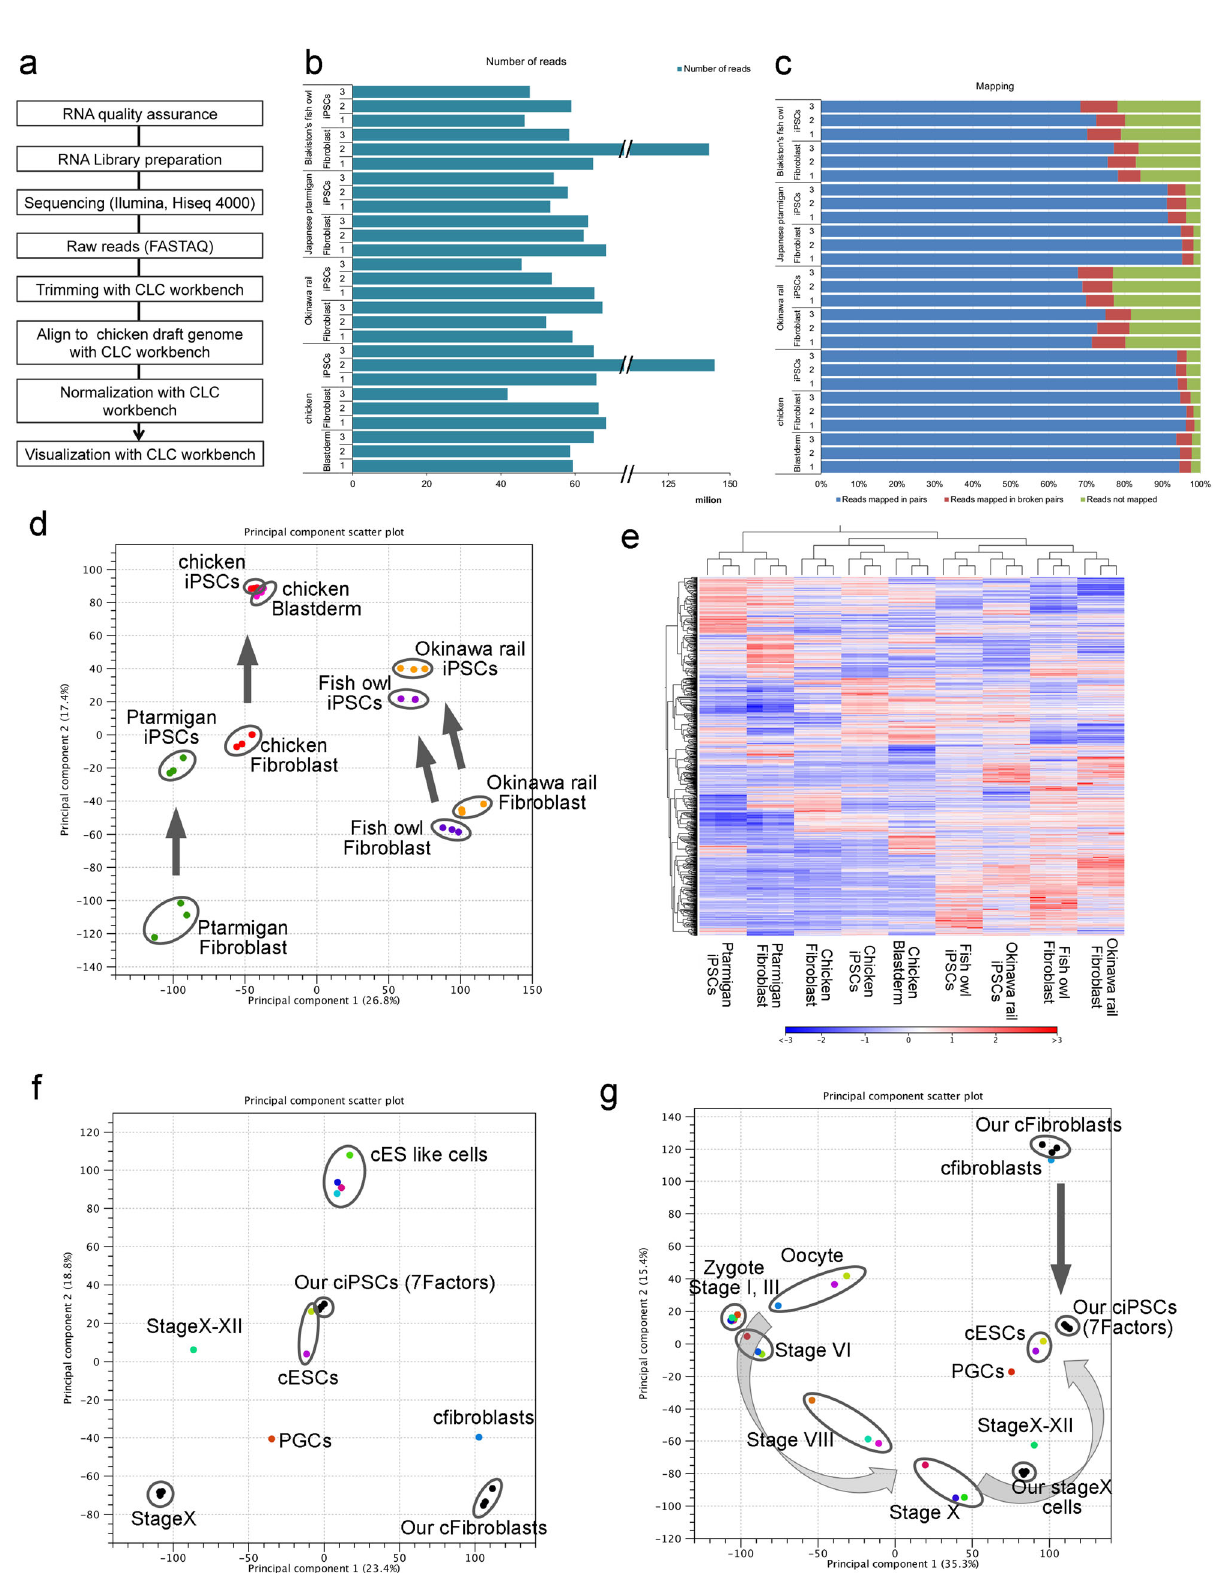
Fig. 9 Global gene expression pro fi le of engendered avian iPSCs with RNA-seq analysis. a Work fl ow of the RNA-seq analysis. b Number of sequence reads for each sample obtained after aligning the chicken draft genome with CLC workbench. c Mapping ratio of each sample. Blue bars show reads mapped in pairs, red bars show reads mapped in broken pairs, and green bars show reads not mapped. d PCA with pro fi ling of endangered avian and chicken iPSCs, endangered avian and chicken fi broblasts, and chicken embryo stage X. e Dendrogram and heat map analysis with pro fi ling of endangered avian and chicken iPSCs, endangered avian and chicken fi broblasts, and chicken embryo stage X. f PCA analysis with pro fi ling of chicken iPSCs (PB-TAD- 7F), chicken fi broblasts, and chicken embryo stage X with SRP115012 (GEO: GSE102353). g PCA with pro fi ling of chicken iPSCs (with PB-TAD-7F), chicken fi broblasts, and chicken embryo stage X with SRP087639 (GEO: GSE86592) and part of SRP115012 (GEO: